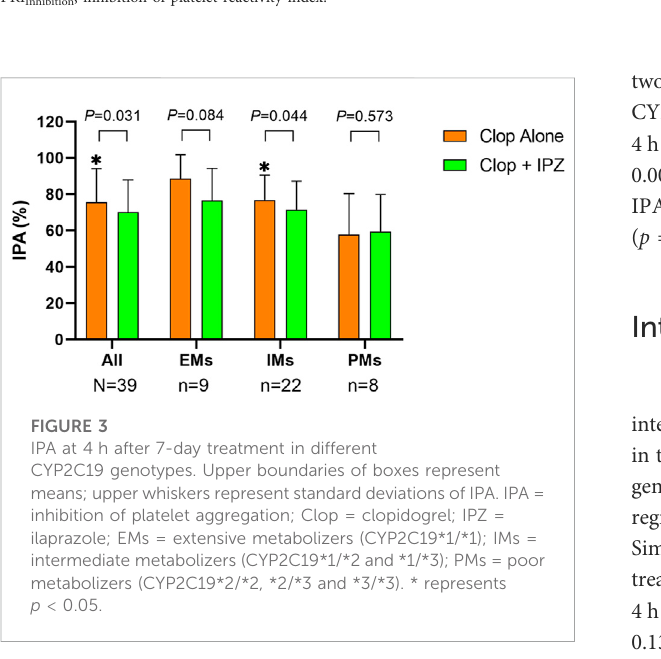
Valuesarepresentedasmean±SD.Abbreviations:PRI,plateletreactivityindex;VASP,vasodilator-stimulatedphosphoprotein;Clop:clopidogrel;IPZ:ilaprazole;CI,con fi dentialinterval; PRI Inhibition , inhibition of platelet reactivity index.